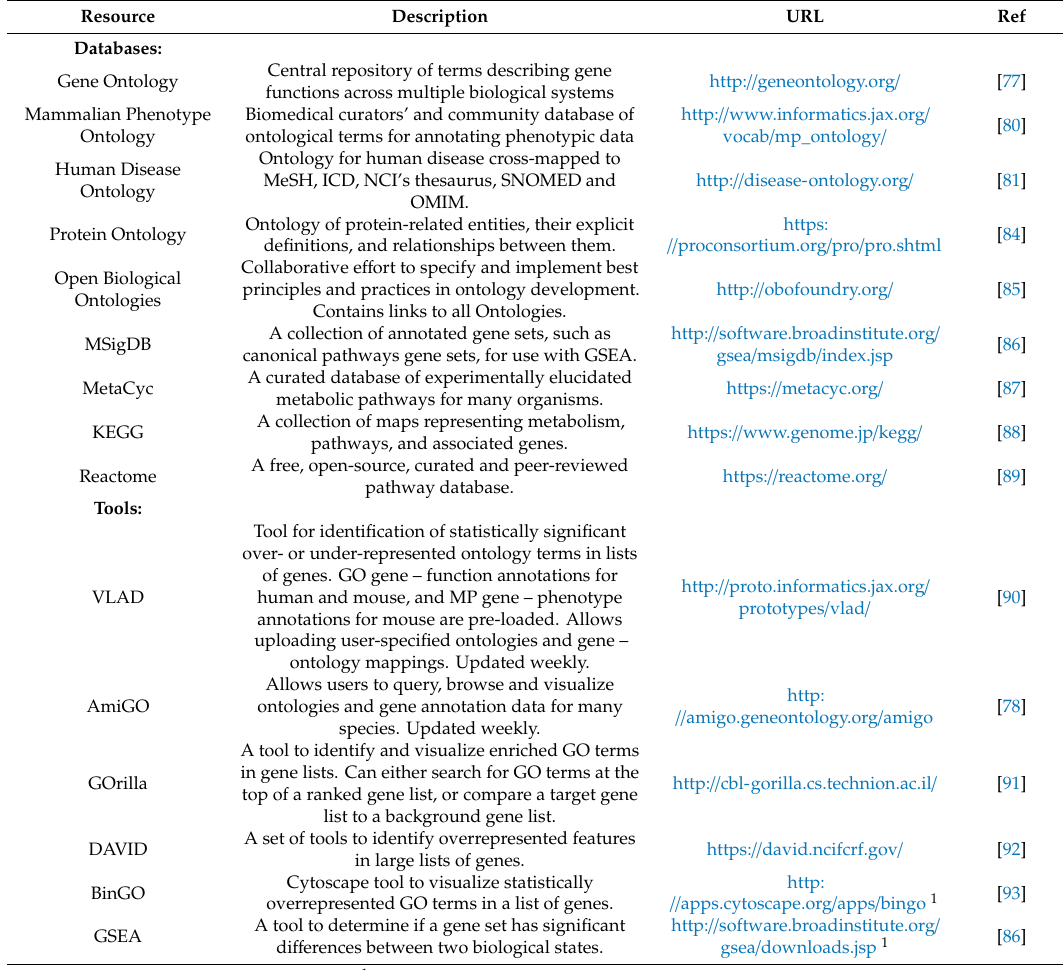
Table 1. Biomedical Ontology and Pathway Databases and Ontology / Pathway Enrichment Tools.